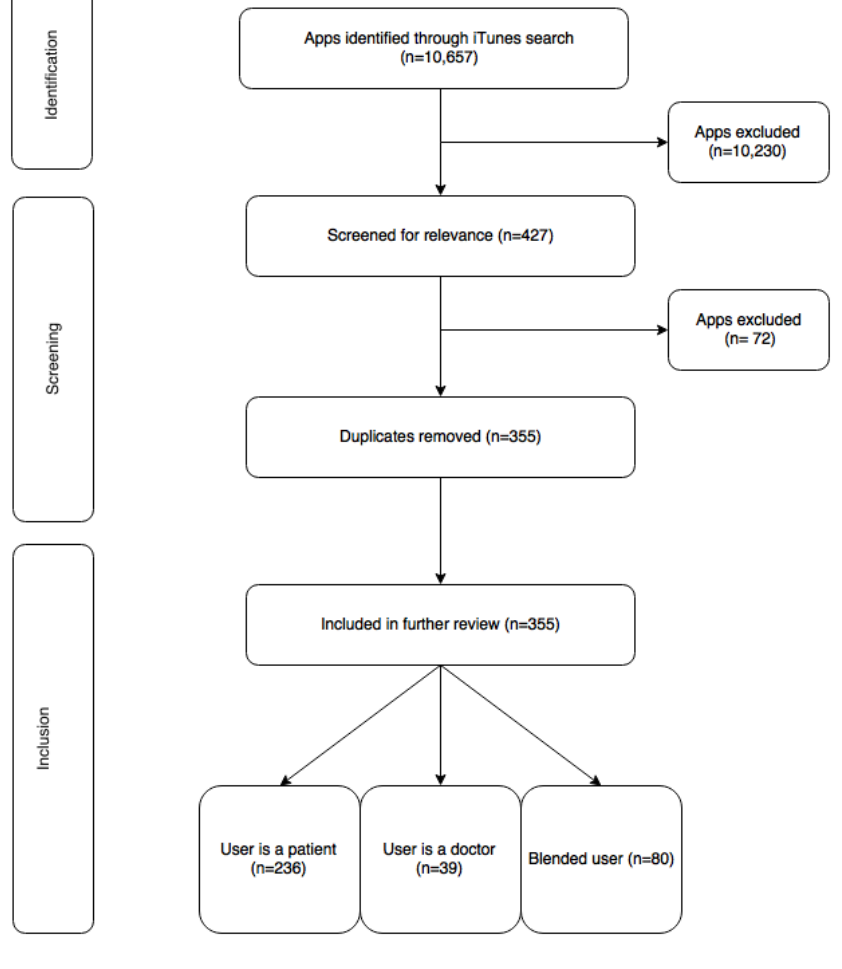
Figure 1. Systematic search for eye-care apps in the Canadian iTunes